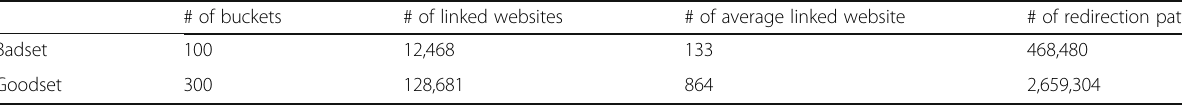
Table 1 Summary results of the seed